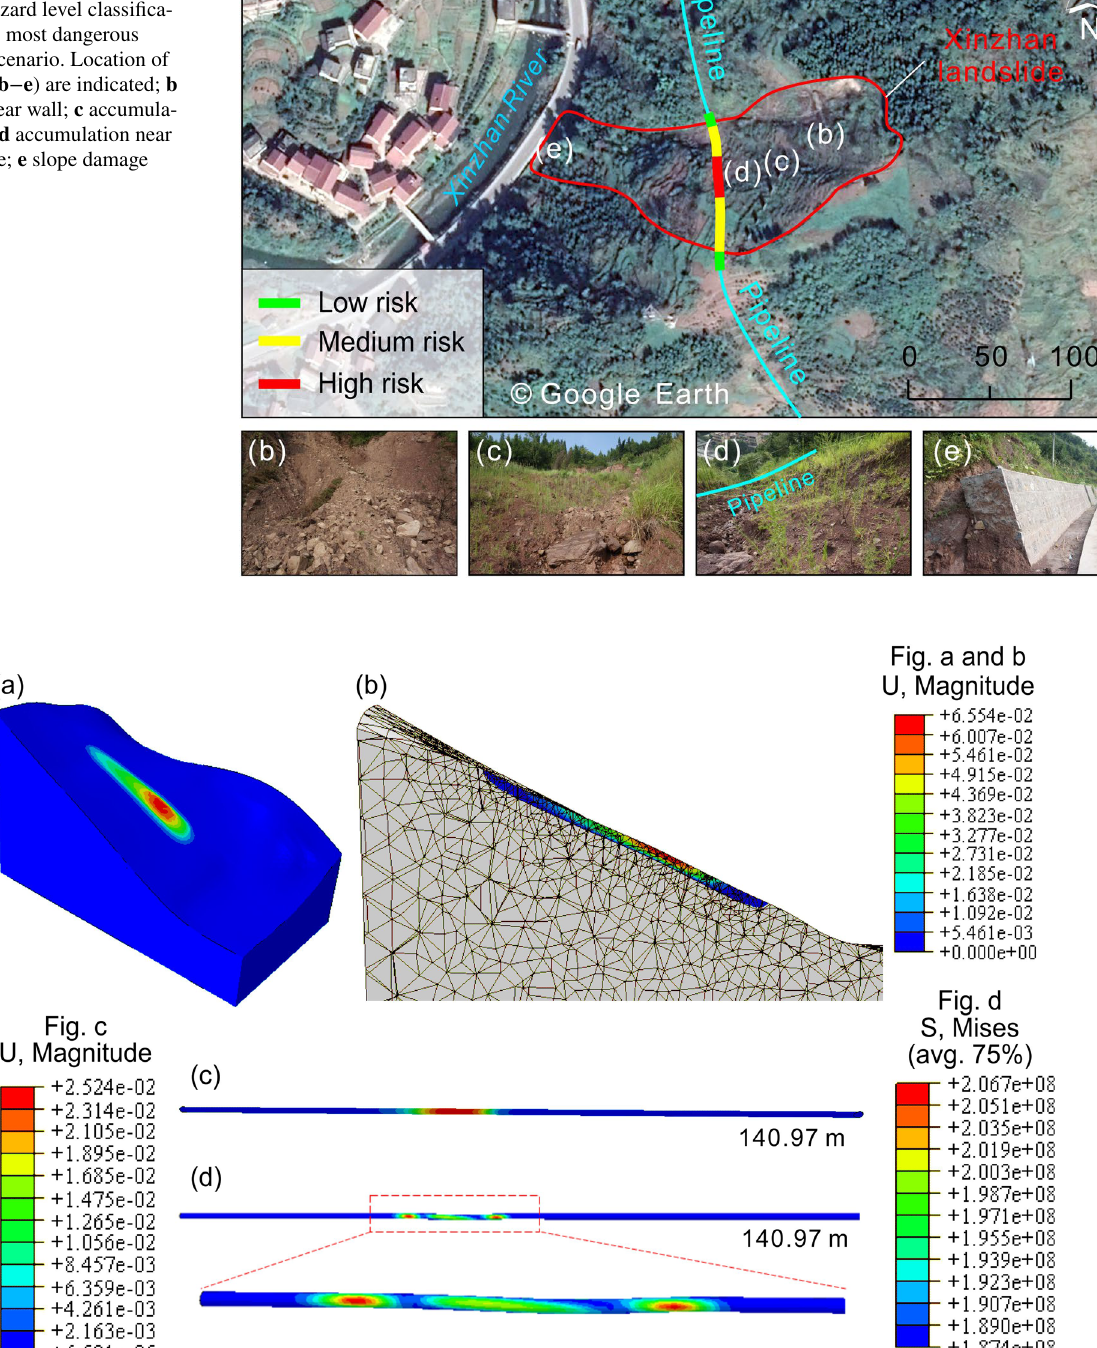
Fig. 8 Pipeline hazard clas- sification for the 2015 Xinzhan landslide. a Results of the pipeline hazard level classifica- tion for the most dangerous landslide scenario. Location of photos in ( b − e ) are indicated; b landslide rear wall; c accumula- tion body; d accumulation near the pipeline; e slope damage